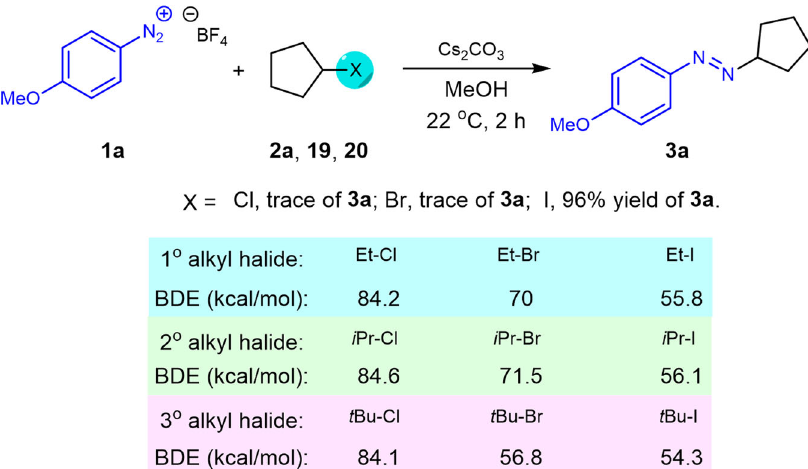
Fig.8|OtheralkylhalidesstudiedincurrentXATprocess. Theresultsemployingcyclopentylchloride,bromide,andiodideasalkylpartnersinourXATtransformation and BDE difference between